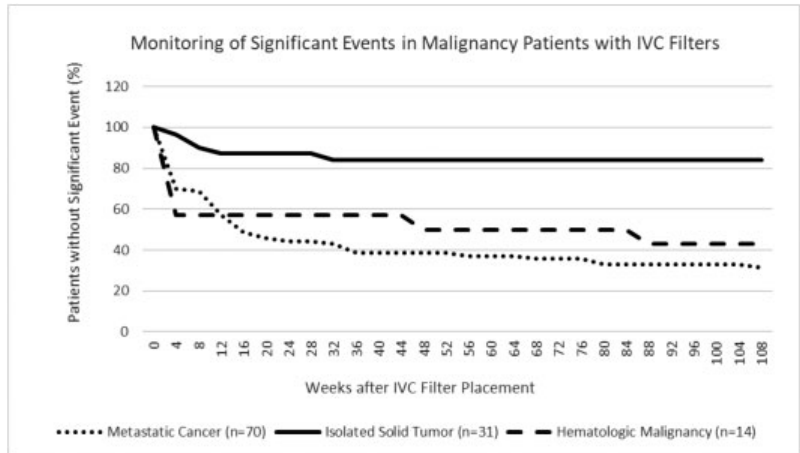
Fig. 1 Plot representing incremental signi fi cant event-free survival of patients after IVC fi lter placement, apportioned by category of malignancy. IVC, inferior vena cava.